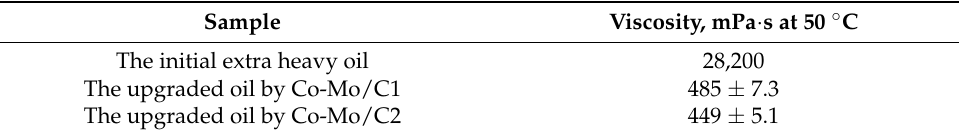
Table 6. Viscosity of the initial extra heavy oil and upgraded oil.